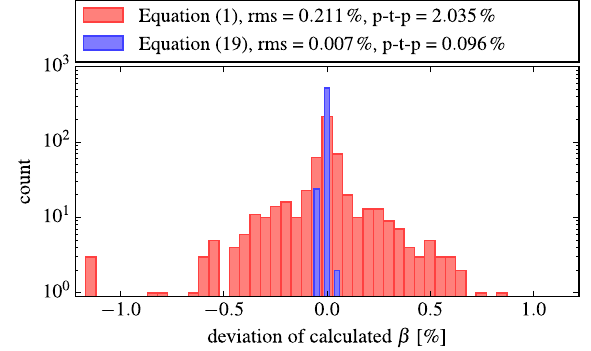
FIG. 4. Accuracy of the horizontal β -function evaluated via Eq. (1) and (19) with the effect of magnets and BPM misalign- ments taken into account. The accuracy of Eq. (19) is similar to the one of Eq. (11) with quadrupolar field errors only (Fig. 2).